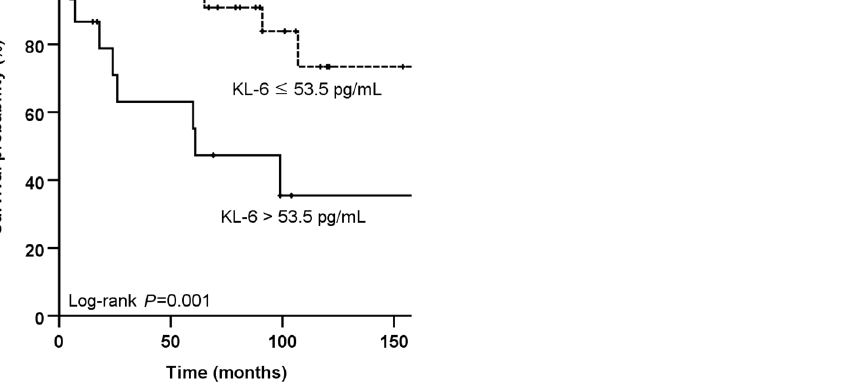
Figure 2. Comparison of the Kaplan–Meier survival curves according to KL-6 levels in patients with SJS-ILD. Vertical axis represents survival probability (%); horizontal axis represents time (months) after diagnosis. Black line indicates high KL-6 group (> 53.5 pg/mL) and dotted line indicates low KL-6 group (≤ 53.5 pg/mL). Vertical bar indicates a censored case. ILD interstitial lung disease, KL-6 Krebs von den Lungen-6, SJS Sjögren syndrome.